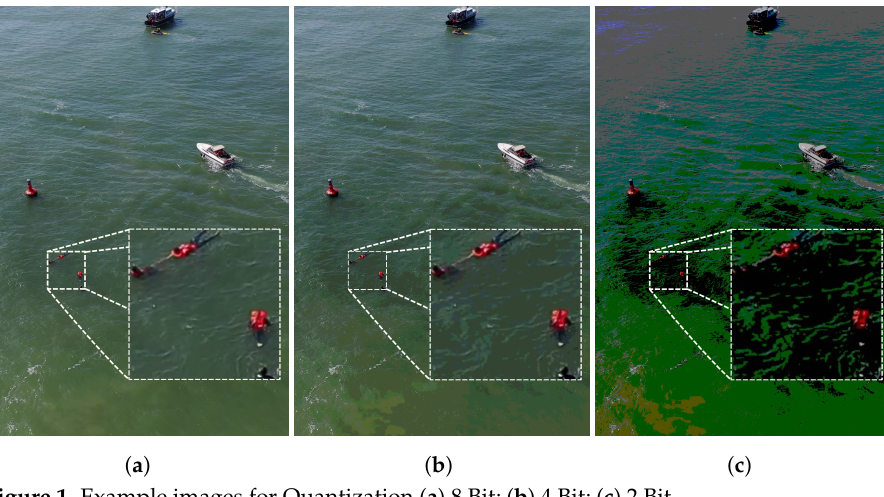
Figure 1. Example images for Quantization.( a ) 8 Bit; ( b ) 4 Bit; ( c ) 2